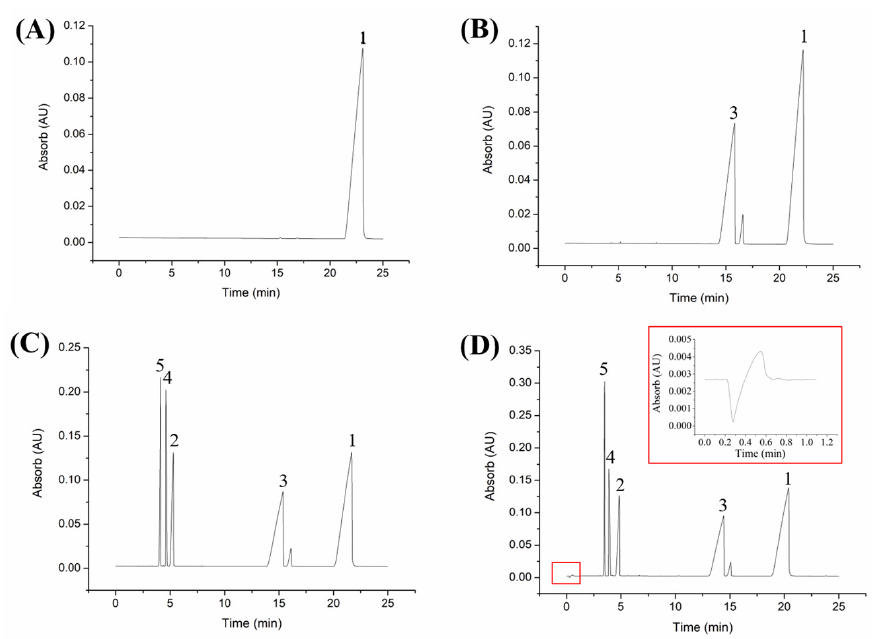
Figure 4. Electropherograms of five compounds at the sample stacking time of 1.0 min ( A ), 0.75 min ( B ),